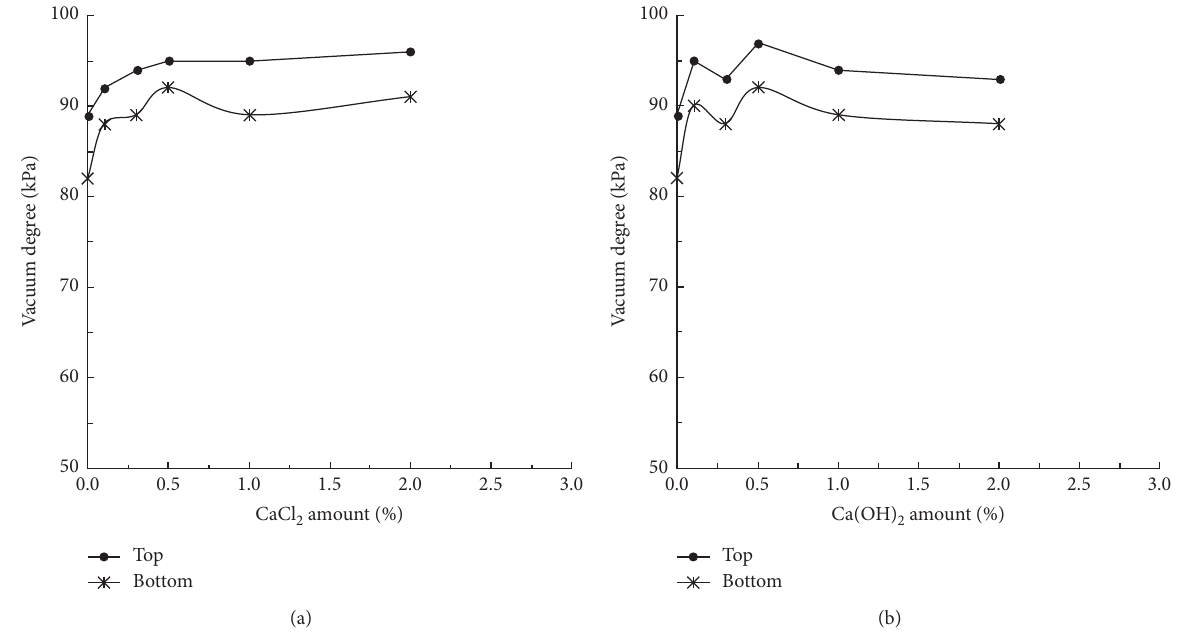
Figure 4: Variation of average vacuum